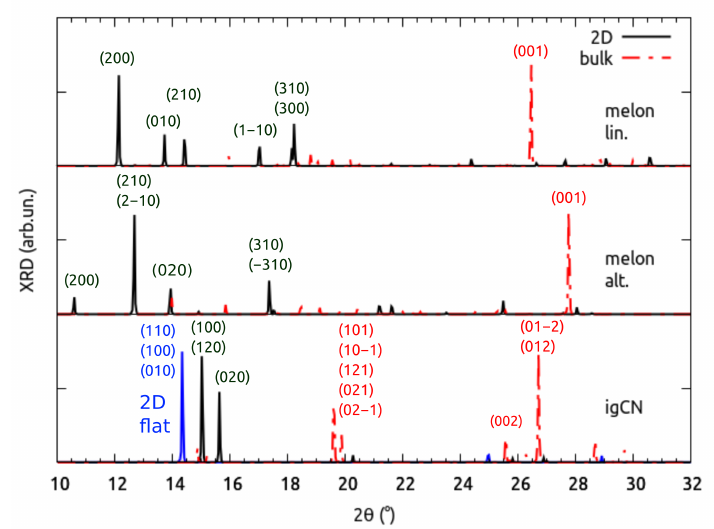
Figure 3. Simulated XRD spectra of optimized gCN models: intensities are scaled in order to match the height of the most intense features. The strongest peaks are labeled with the indices of reflection